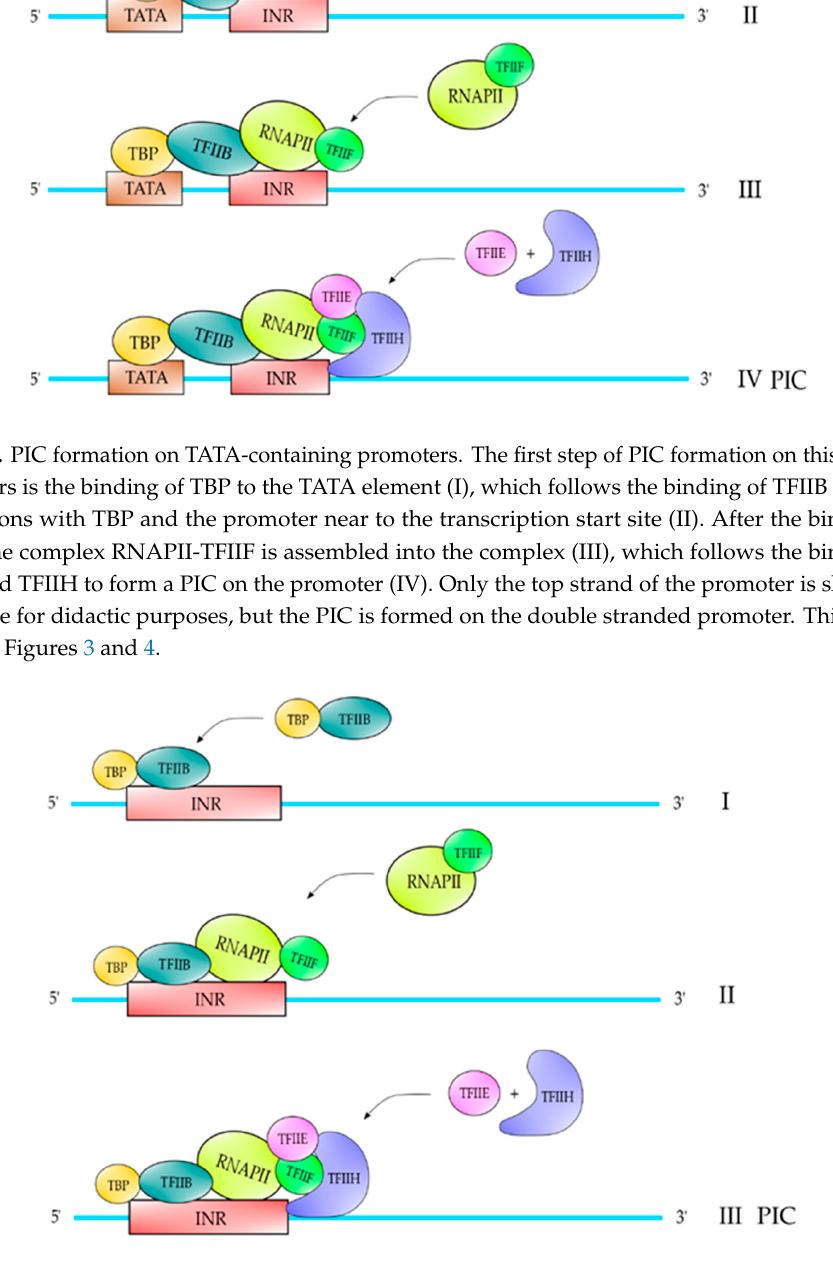
Figure 3. PIC formation on an INR-containing promoter. In those promoters that contain an INR, the complex TBP-TFIIB binds to this element (I) and after the complex RNAPII-TFIIF enters the complex (II), which follows the binding of TFIIE and TFIIH to complete the PIC formation (III). This model of PIC formation has not been published yet, but we have determined this pathway using pure RNAPII and recombinant factors from fission yeast and the nmt1 promoter in which the TATA box was deleted.